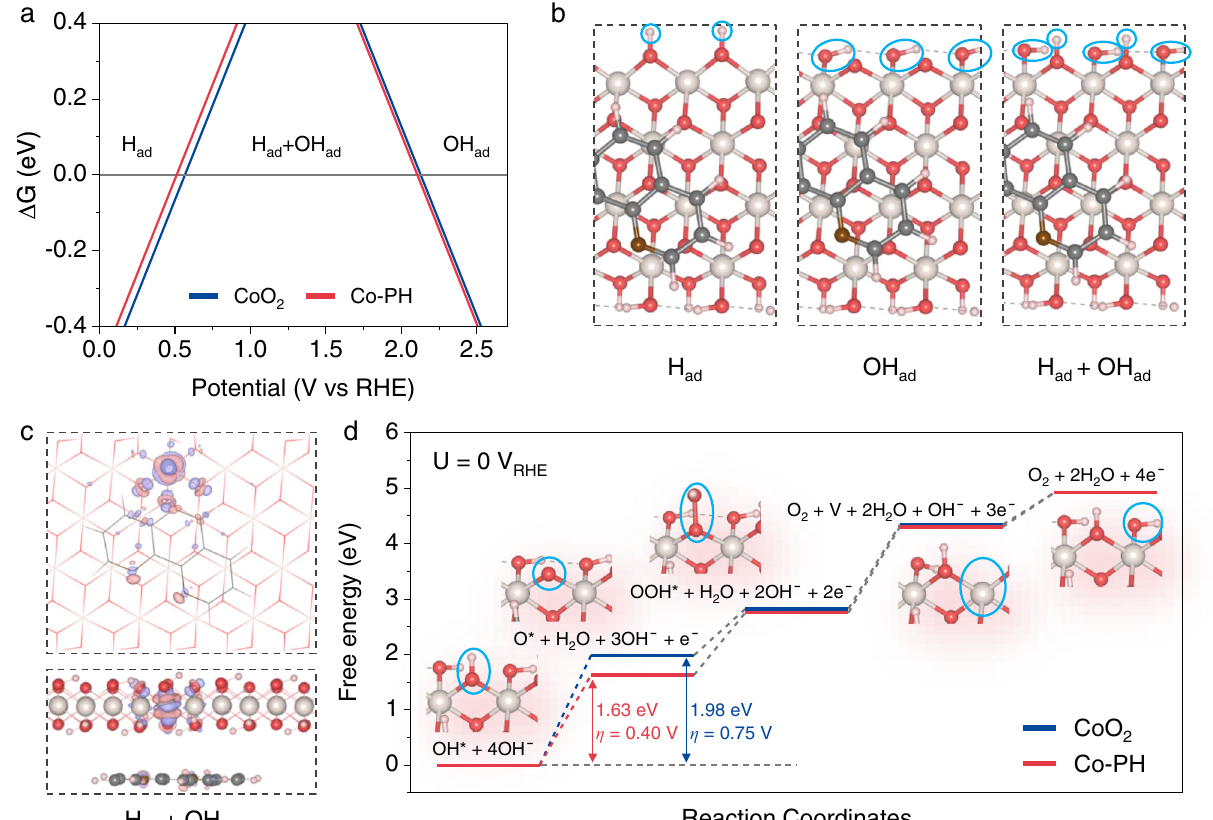
Fig. 7 | OER mechanism. a Surface free-energy diagram of CoO 2 and Co-PH respective to the surface saturated with hydrogen adsorption (H ad ) on bridge O (O bri ) and OH adsorption (OH ad ) on coordinatively unsaturated sites. b The struc- tures of different surface phases on Co-PH, and adsorbates of surface phases are highlighted by light blue circles on the top views. c The top view (upper) and side view(under)ofchargedensitydifferencesofCo-PHthatsurfacesaturatedwithH ad